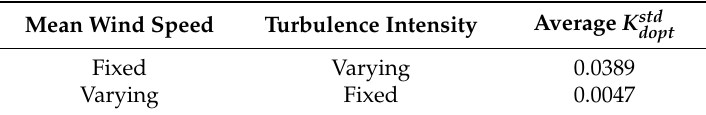
Figure 10. T i - K dopt curves under different mean wind speeds.